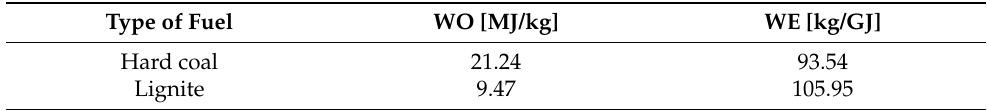
Table 6. Average heating values (WO) and CO 2 emission ratios (WE) of coal used by power plants and heat and power generating plants in